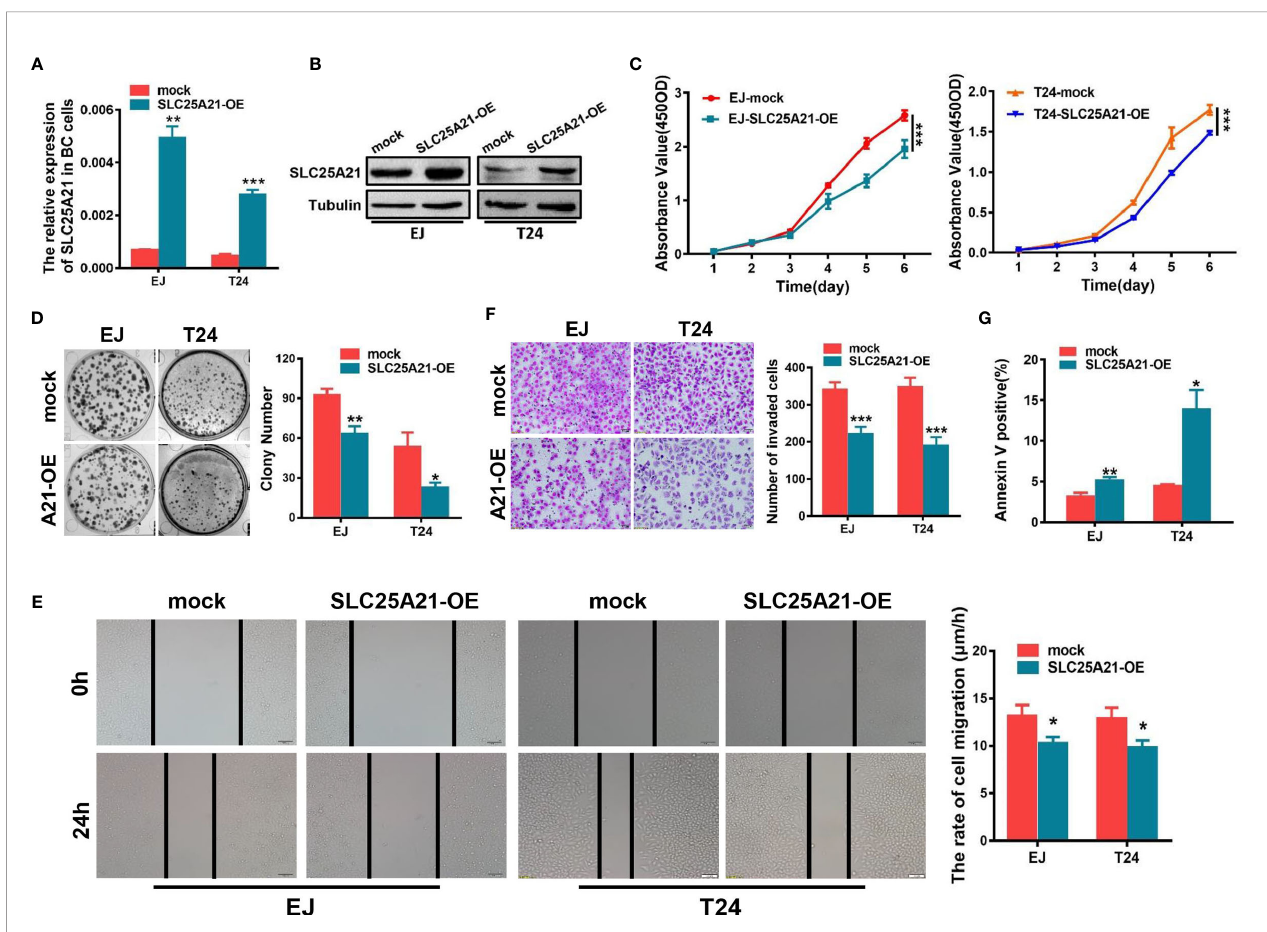
FIGURE 2 | SLC25A21 overexpression inhibits the cell proliferation, migration and invasion and induces the apoptosis of BCa cells in vitro . (A, B) Increased expression of SLC25A21 after transfection of the pcDNA3.1-SLC25A21 vector was con fi rmed in two BCa cell lines by real-time RT-PCR (A) and western blotting (B) . (C) SLC25A21 overexpression inhibits the proliferation of EJ and T24 cells. (D) SLC25A21 overexpression decreased the colony formation capacity of EJ and T24 cells. (E) The migration ability of BCa cells overexpressing SLC25A21 was decreased, as indicated by the wound healing assay. (F) Matrigel invasion chamber assays showed that SLC25A21 overexpression inhibited the invasiveness of both EJ and T24 cells. Representative images (left) and quantitative analyses (right) are shown. (G) SLC25A21 overexpression induced the apoptosis rate relative to control cells. Data are presented as the mean±SD. The results were reproducible in three independent experiments. * P <0.05, ** P < 0.01, and *** P <